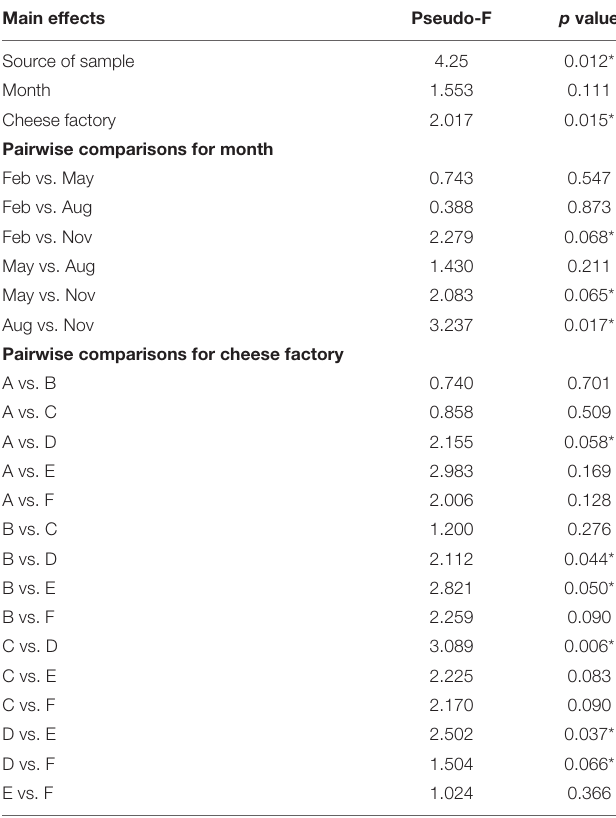
TABLE 4 | PERMANOVA analysis (999 permutations) results for bacterial communities based on weighted UniFrac distances, respectively.